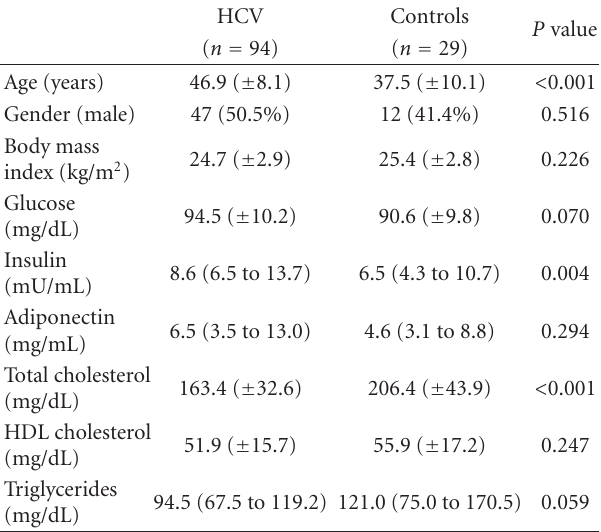
Table 1: Characteristics of the patients with chronic hepatitis C and controls.